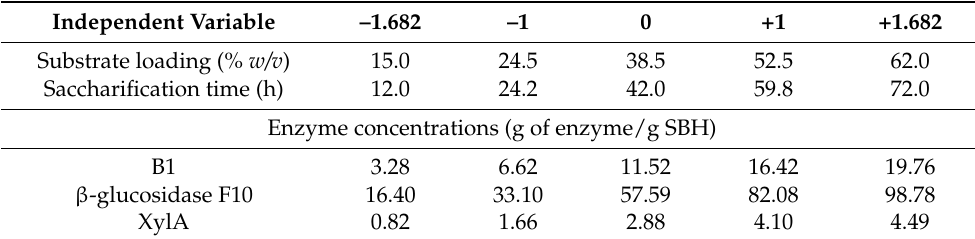
Table 1. The independent and coding levels employed in the